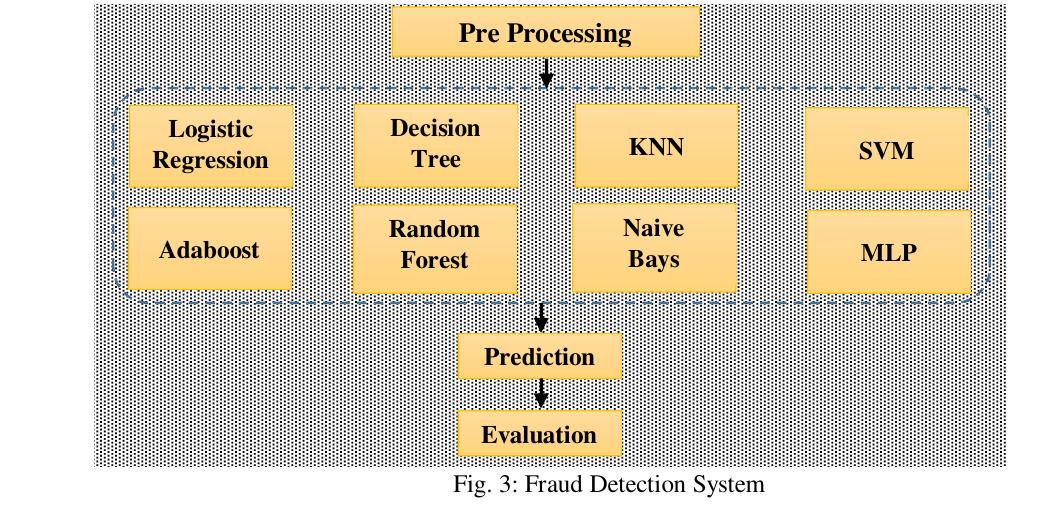
Fig. 3: Fraud Detection